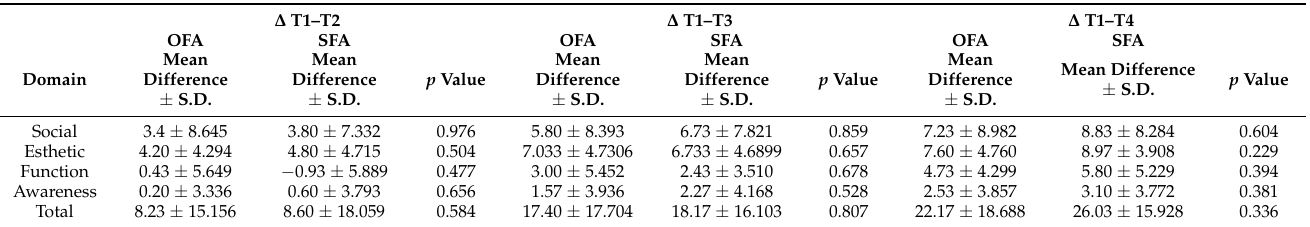
Table 4. The mean differences at each time point, and comparisons between the OFA and SFA groups, using the Mann–Whitney U test.